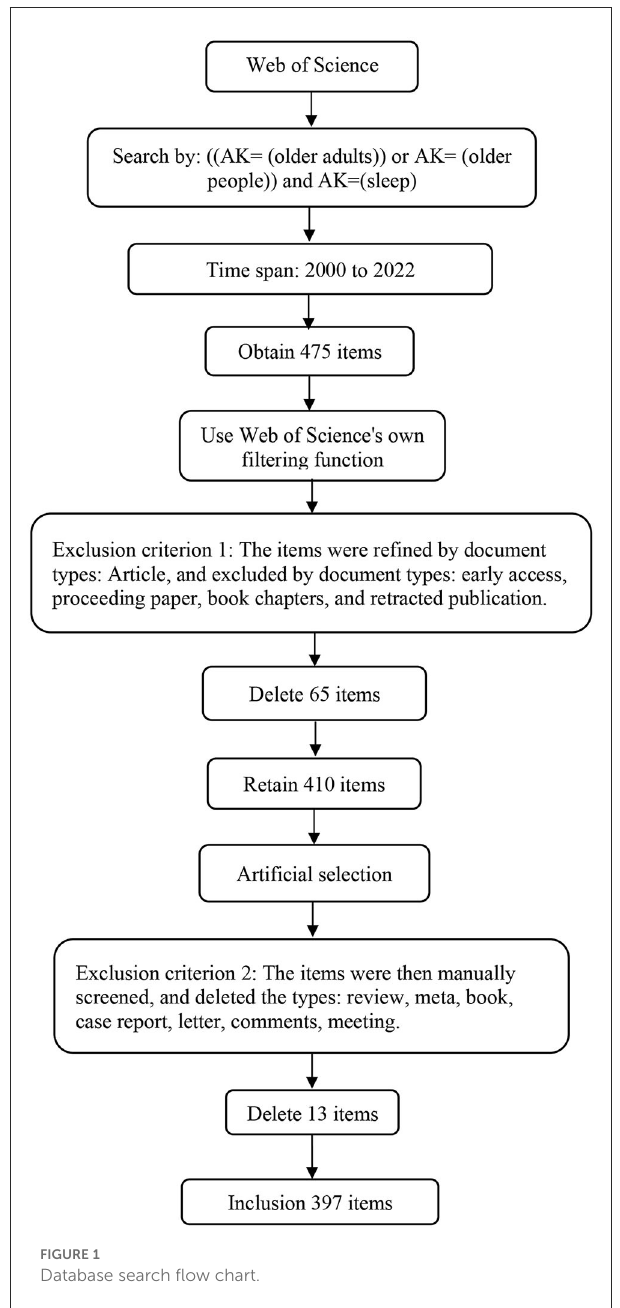
FIGURE1 Database search flow